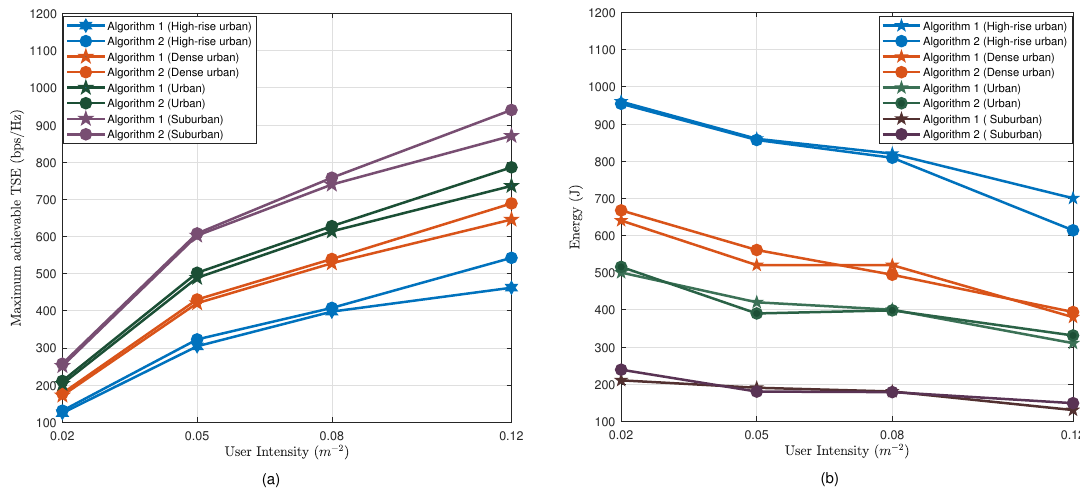
Figure 10. ( a ) Maximum achievable total spectral efficiency (TSE) vs. user intensity ( b ). Energy consumption for maneuvering vs. user